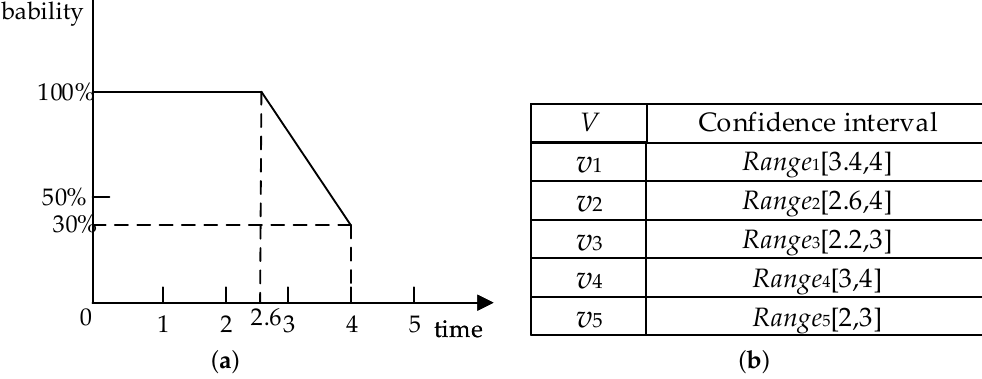
Figure 6. The decreasing function image of the node v 2 and the confidence interval of each node. ( a ) The decreasing function image of the node v 2 ; ( b ) The confidence interval of each